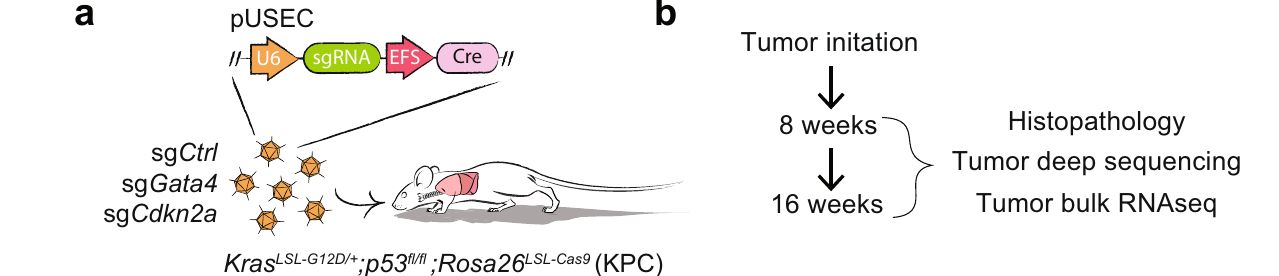
from sg Gata4 - and sg Ctrl -targeted tumor-bearing mice. RNA-seq of bulk tumors revealed a number of differentially expressed genes between Gata4 -targeted tumors and controls (Fig. 2a-b, Supplementary Data 1). Geneset enrichment analysis (GSEA) on the list of differentially expressed genes showed that pathways depleted in Gata4 -targeted tumors relative to controls include in fl ammatory pathways, such as interferon-beta